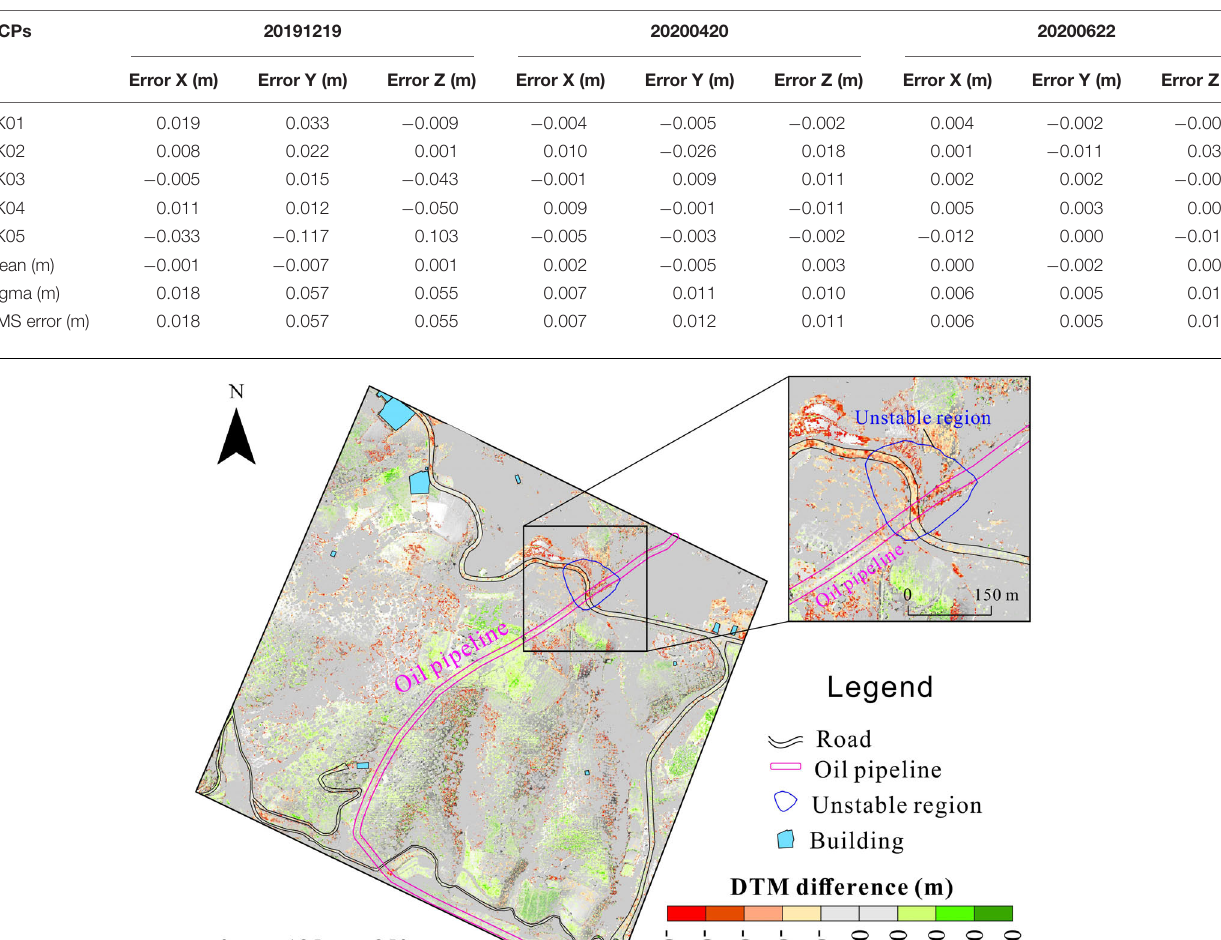
TABLE 4 | Accuracy evaluation results of UAV ground control points.